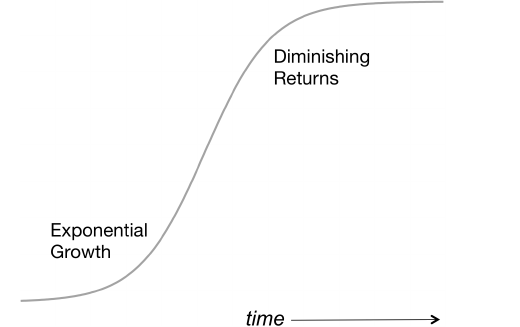
Figure 5. Illustration of the logistic